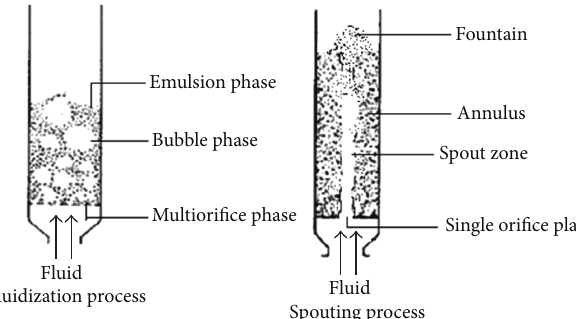
Figure 1: Different regions of fluidized/spouted bed.